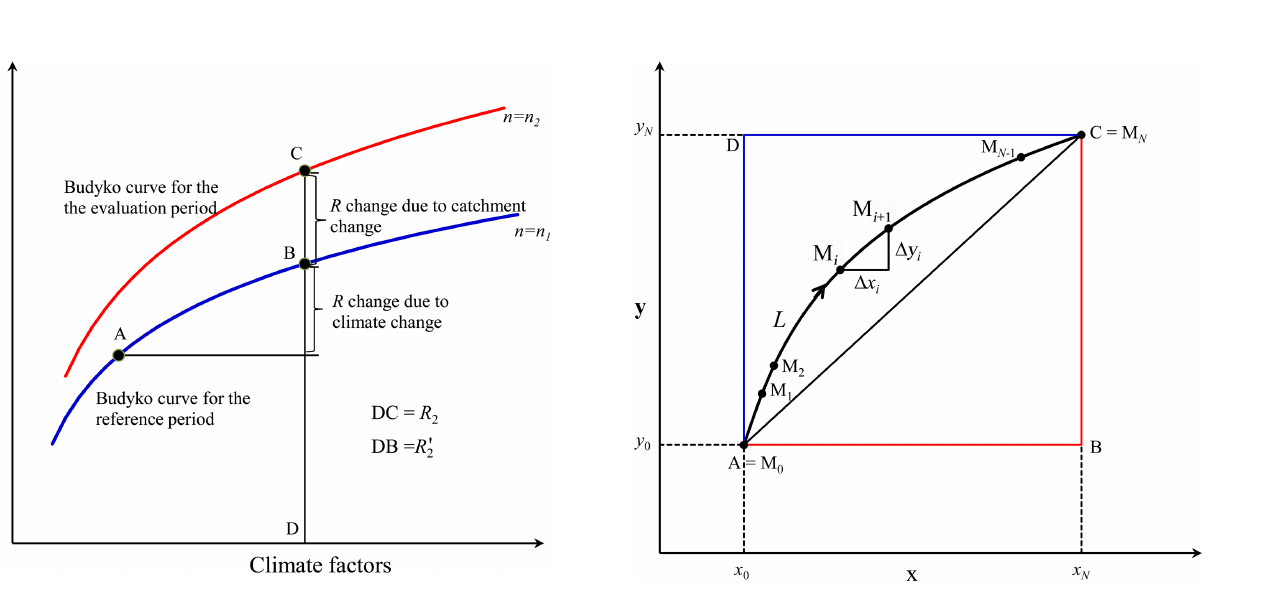
Figure 3. A schematic plot illustrating the LI